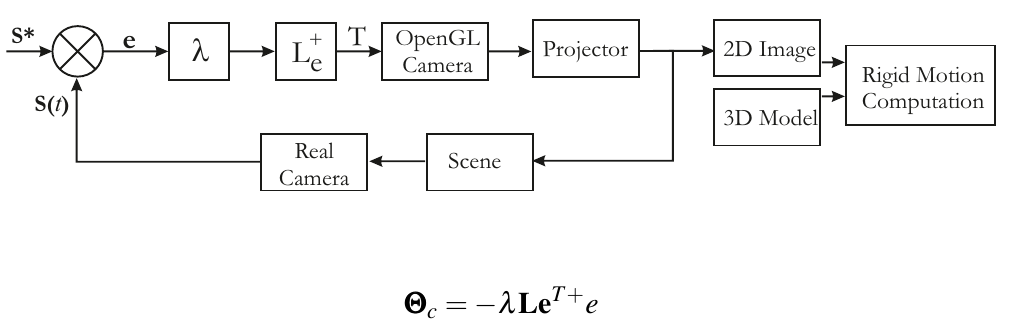
Figure 7. Calibration based on visual